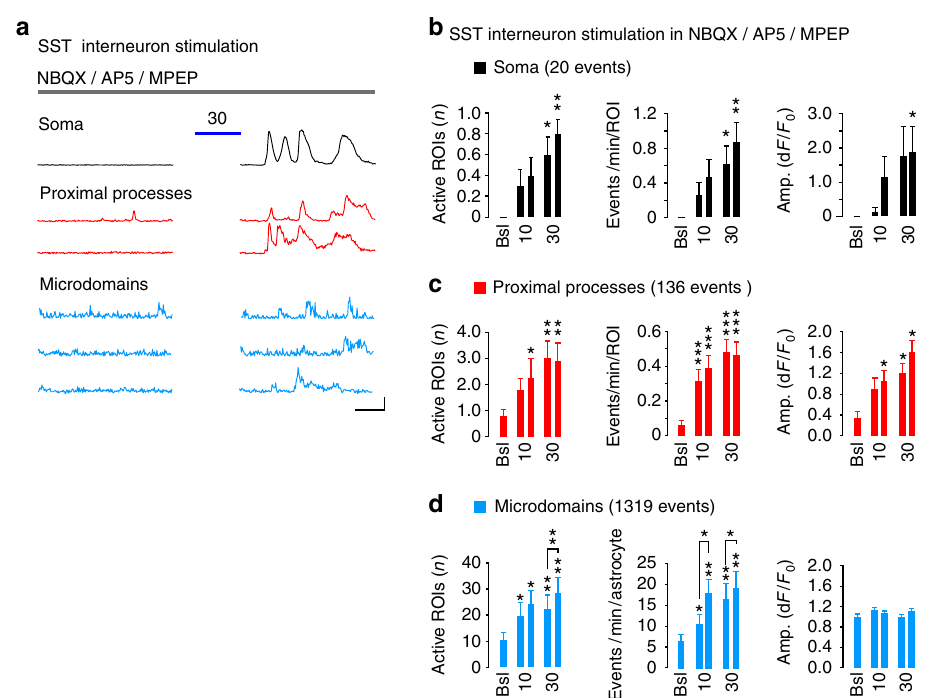
Fig. 3 Astrocyte response to SST interneurons does not depend on glutamatergic transmission. a Representative traces and b – d quantitative evaluation of GCaMP6f-astrocyte responses to SST interneuron activation (10 or 30 light pulses) in SSCx slice preparations (9 astrocytes, 9 slices, 3 mice) in the presence of NBQX (10 µ M), D-AP5 (50 µ M), and MPEP (50 µ M). Scale bars, 20 s, 50% d F / F 0 . Data are means ±